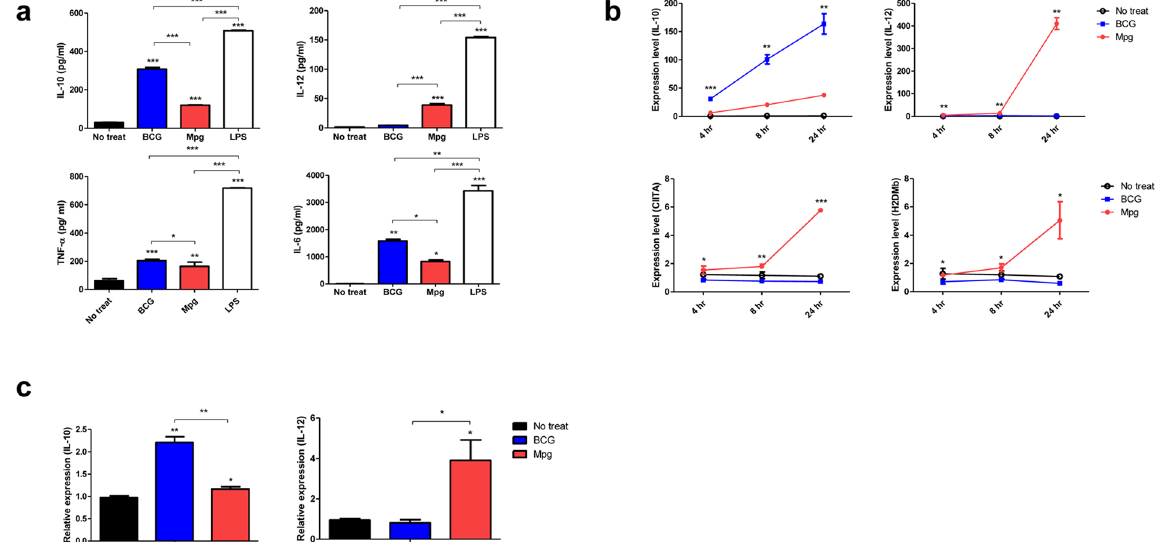
Figure 3. M . paragordonae (Mpg) induced BMDC or THP-1 -mediated immune responses. ( a ) Supernatants of the infected BMDCs were collected, and IFN- γ , TNF- α , IL-2, and IL-10 cytokine levels were analyzed by ELISA ( * P < 0.05, ** P < 0.01, *** P < 0.001; Student’s t -test). ( b ) qRT-PCR was used to measure the expression levels of IL-10, IL-12, CIITA and H2DMb mRNA in the BMDCs infected with BCG or Mpg. The expression levels represent relative fold changes based on β -actin. ( c ) qRT-PCR was used to measure the expression levels of IL-10 and IL-12 mRNA in the THP-1 cells infected with BCG or Mpg. The expression levels represent relative fold changes based on 18S rRNA. ( * P < 0.05, ** P < 0.01, *** P < 0.001; Student’s t